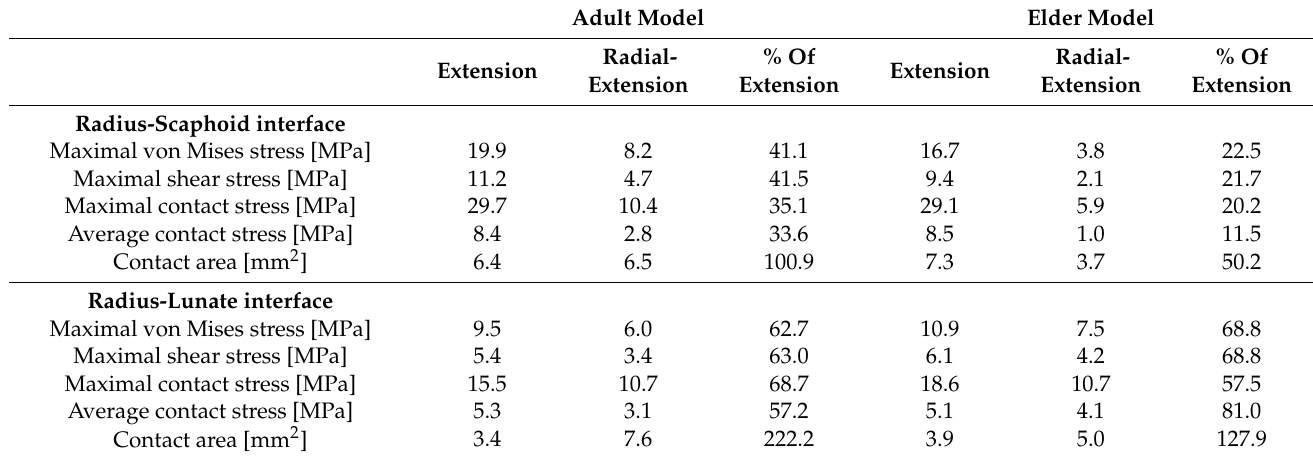
Figure 4. ( a ) von Mises stresses [MPa] and ( b ) min principal stress on the Radius cartilage [ MPa ] for the adult model (left) and elder model (right): (upper) extension , (bottom) radial extension . Table 2. Maximal von Mises stresses, maximal shear stresses, maximal and average contact stresses [ MPa ] and contact area [ mm2 ] in extension and radial-extension models in the adult and elder simulations. The percent of variable in the radial-extension model in relation to the extension model is calculated and presented as “ % of Extension